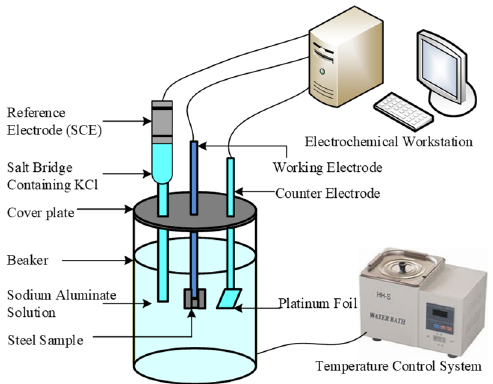
Figure 2. Schematic diagram of electrochemical workstation.